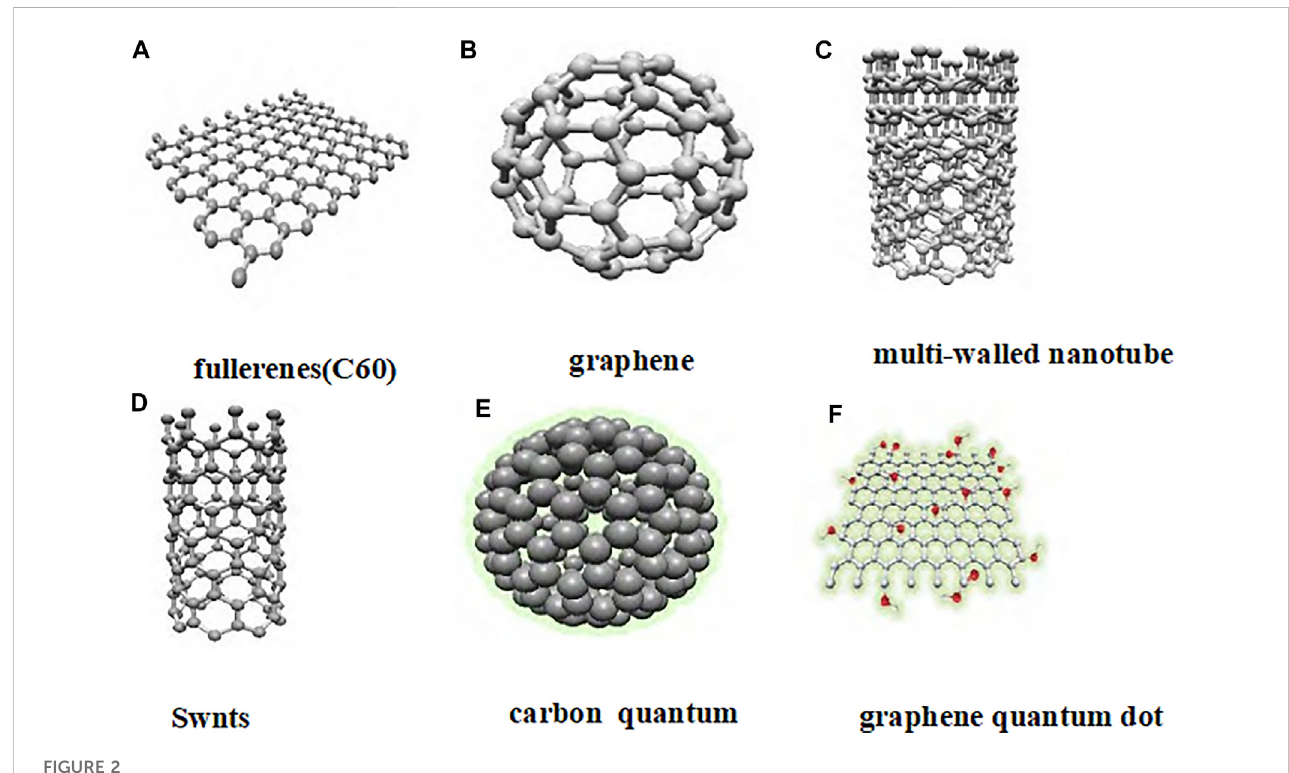
FIGURE 2 Different types of carbon